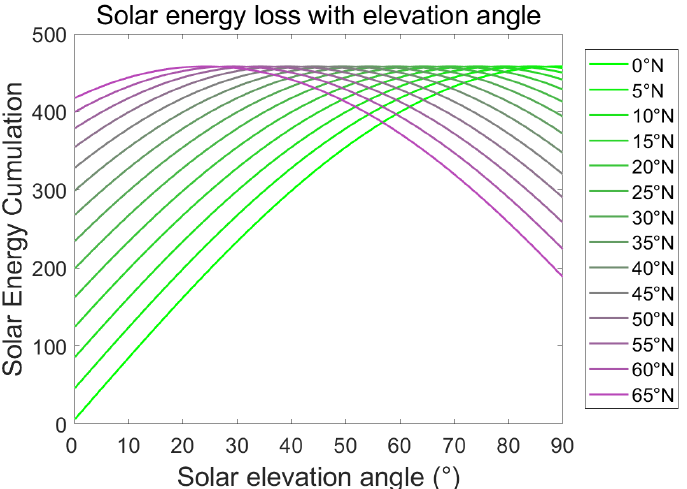
Figure 10. The date is 20 February 2019. The horizontal coordinate indicates the solar tilt angle set- ting; the vertical coordinate indicates the measure of r i ·r 0 accumulated on that day (no units).